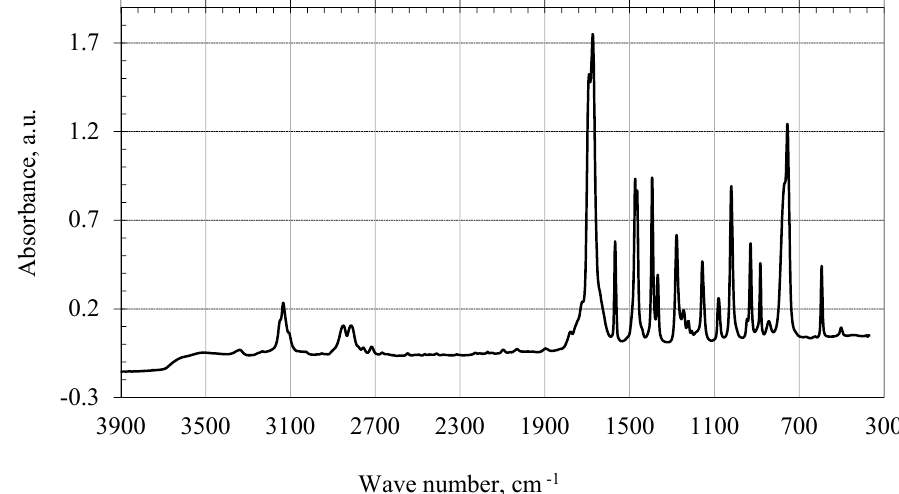
Figure 6. IR spectrum of 2-furaldehyde.